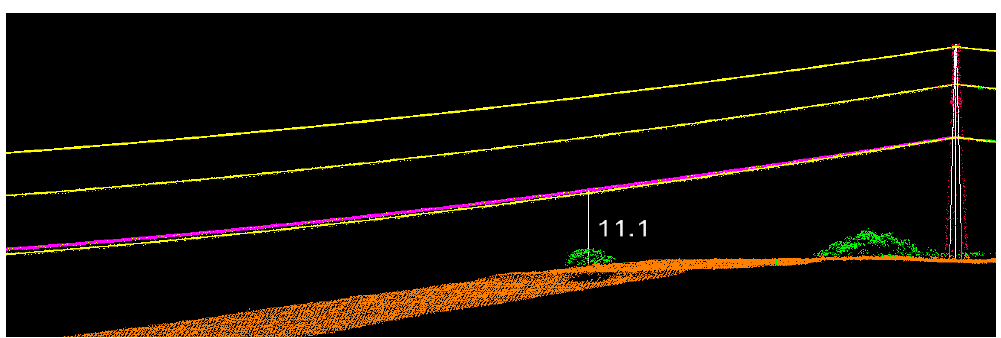
Figure 1. Determination of the conductor minimum height above the terrain.